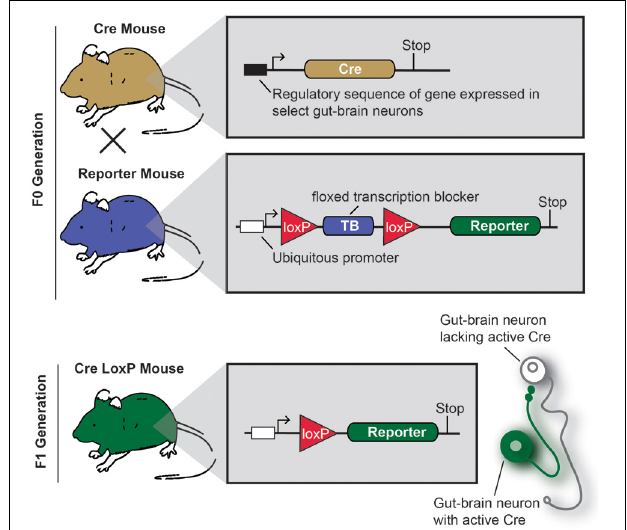
FIGURE 3 | Principle of an experiment using the Cre-LoxP system to label specific gut-brain axis neurons in the